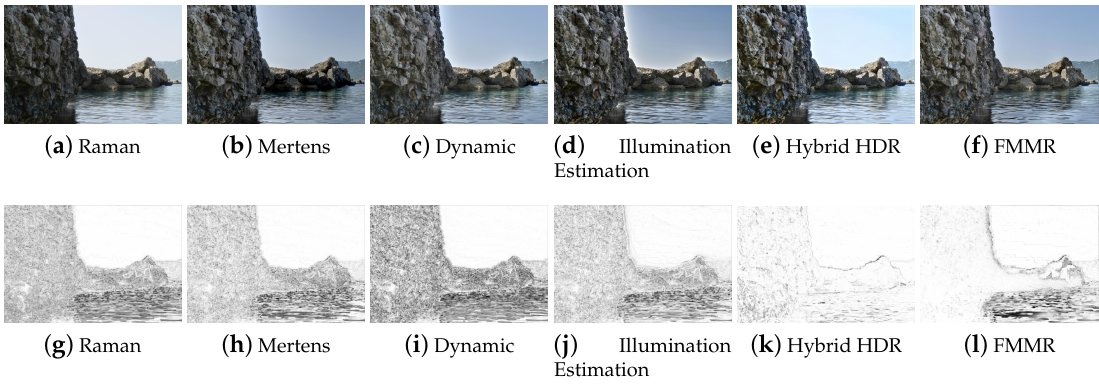
Figure 7. Comparison of the six MEF algorithms in terms of structural similarity. White colors show high structural similarity, whereas dark colors demonstrate low structural